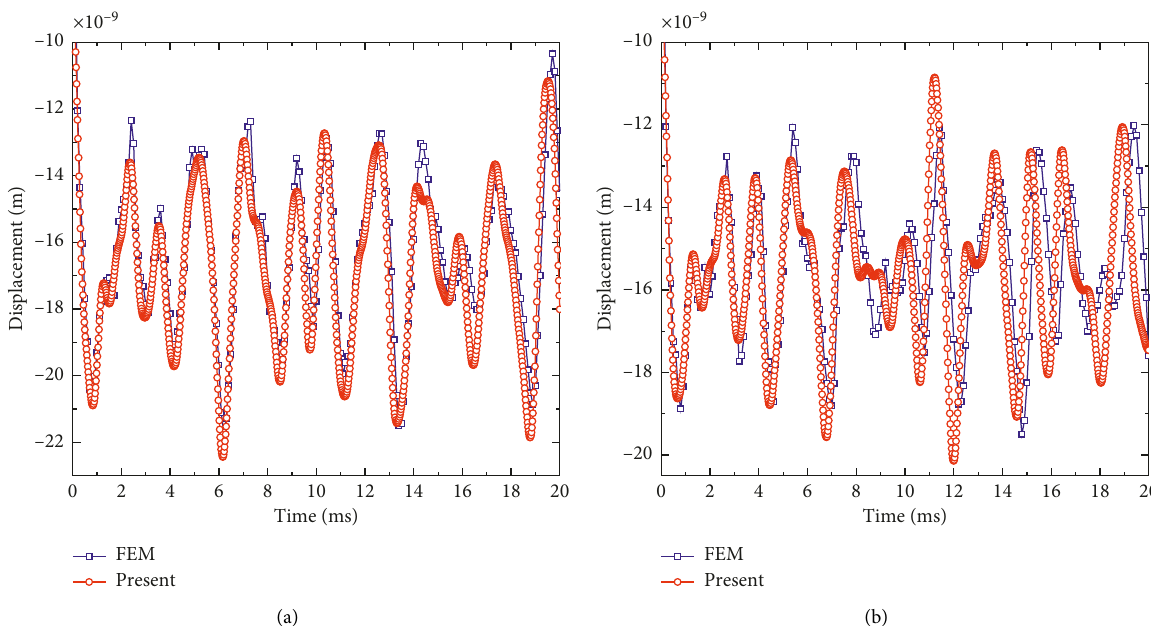
Figure 8: The comparison of normal displacement response of FG-CNTRC plate. (a) Non-stepped FG-CNTRC plate. (b) Multi-stepped FG- CNTRC